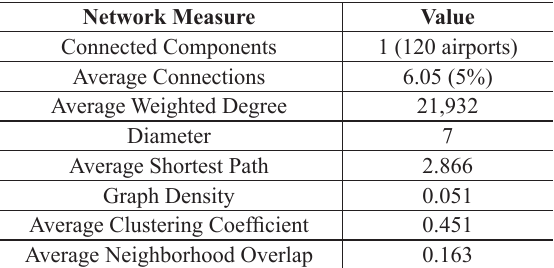
Network metrics - National